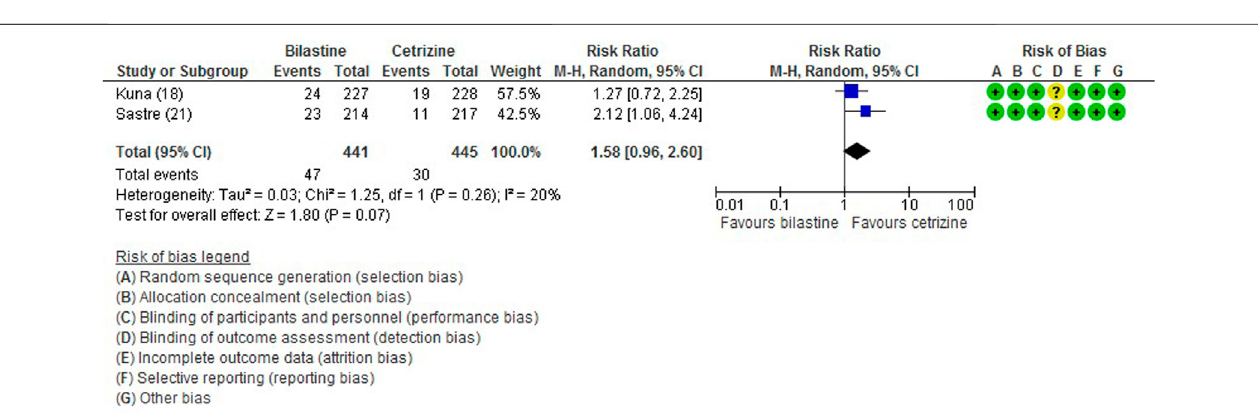
FIGURE 9 | Comparison between bilastine and cetirizine for headache. CI Con fi dence interval, df degrees of freedom.